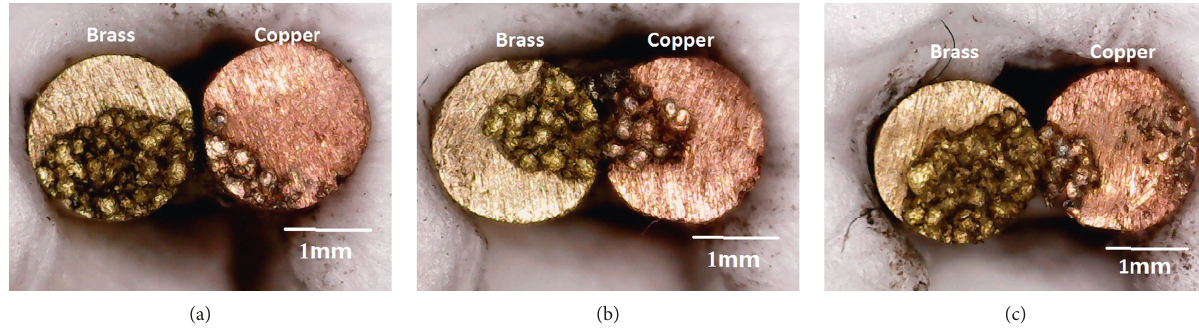
Figure 4: Discharge point distribution on the surface of brass and copper electrodes.